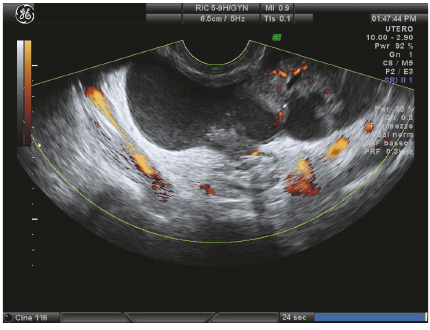
Figure 3: Case four: left adnexal mass